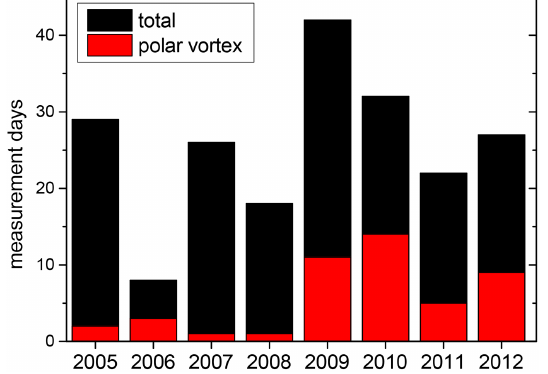
Figure 5. Number of days with coincident MIR and NIR FTIR mea- surements at Ny-Ålesund. Black: total number; red: only measure- ment days when the station has been inside the polar vortex.